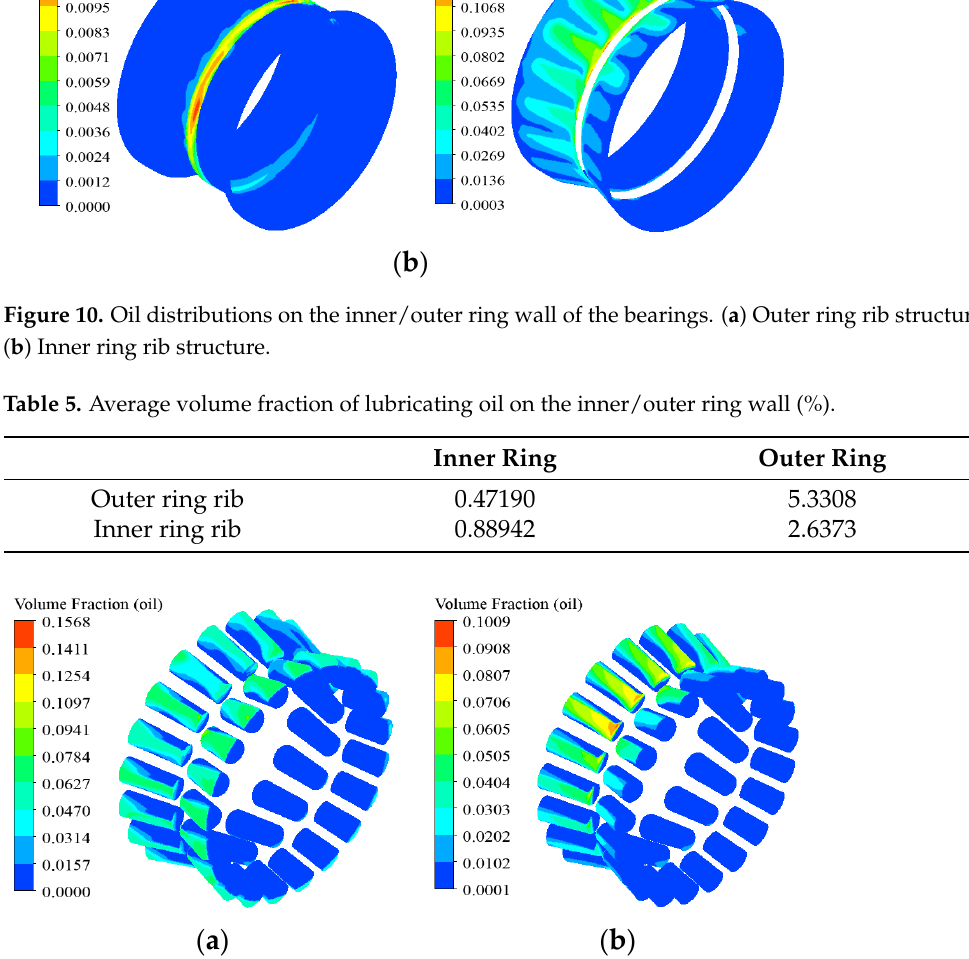
Table 5. Average volume fraction of lubricating oil on the inner/outer ring wall (%).